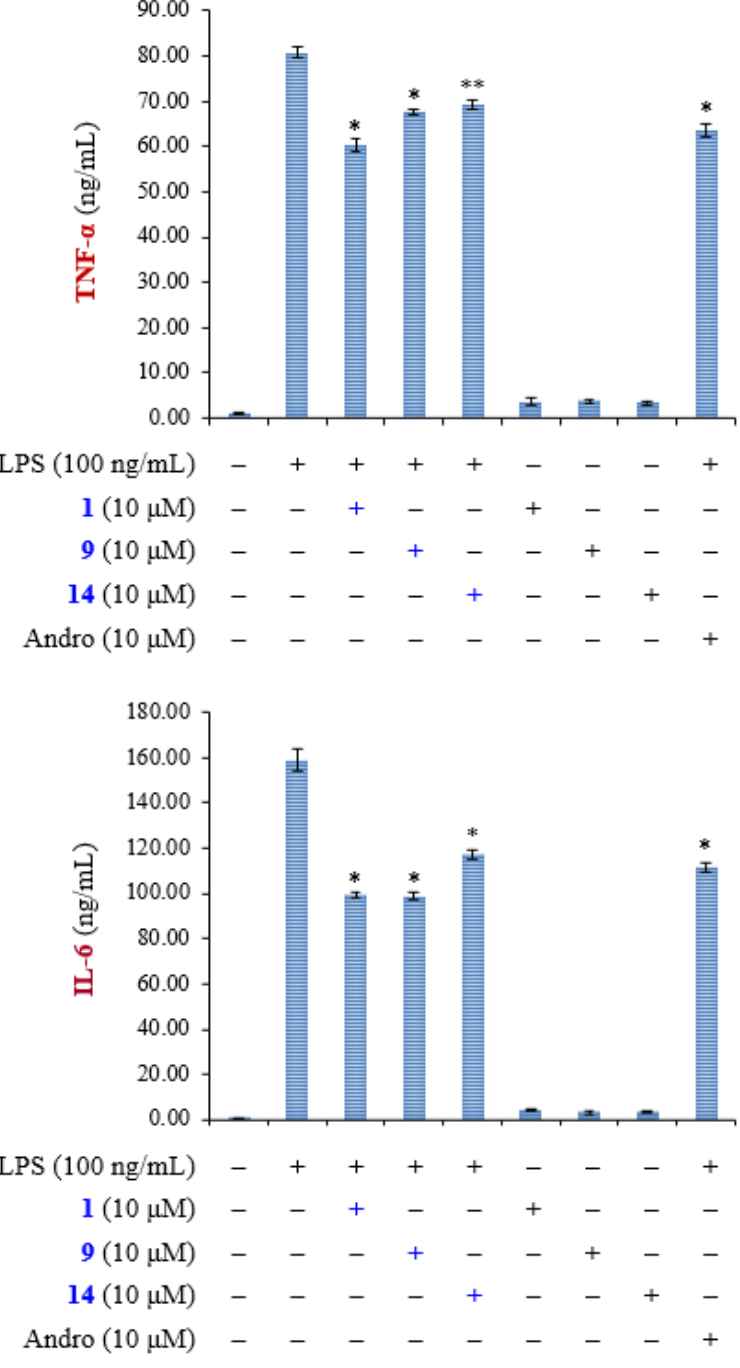
Figure 5. Compounds 1 , 9 , and 14 suppress the production of proinflammatory cytokines TNF-α and IL-6 in LPS-stimulated RAW 264.7 macrophages. Andrographolide (Andro) was used as positive control. Results are displayed as mean ± SEM ( n = 3) of three independent experiments. “+” means treatment with LPS or compound. “−” means no treatment with LPS or compound. Asterisks indicate significant differences (* p < 0.05, ** p < 0.01) compared with the control.